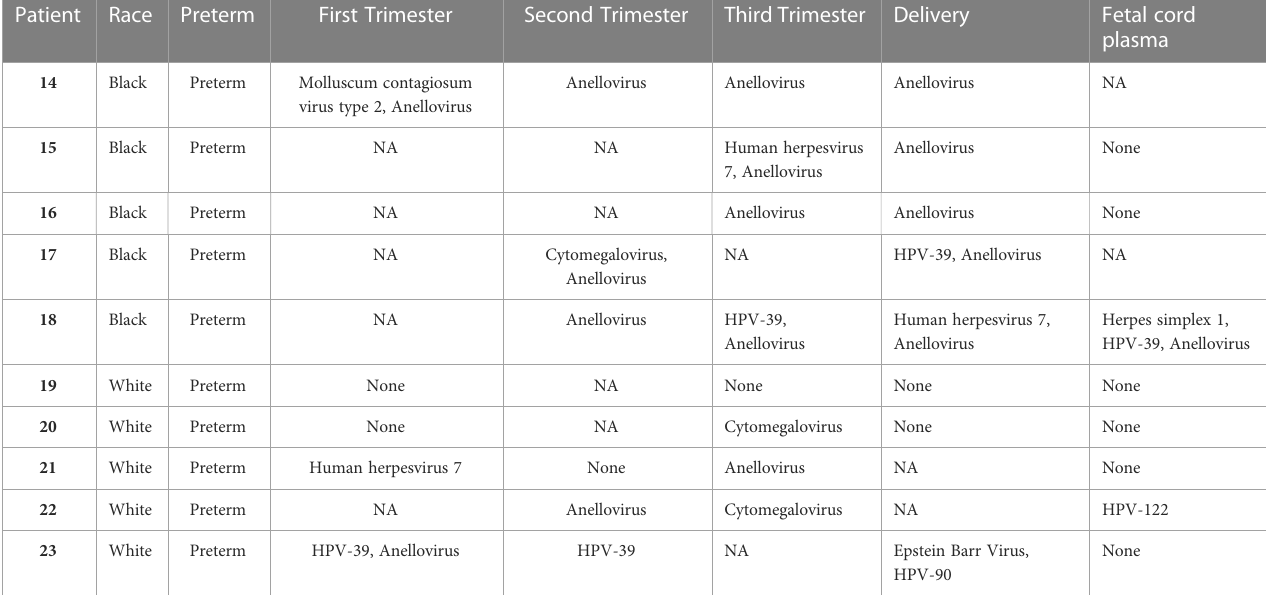
including the Betatorquevirus torque teno mini virus 3 and Gammatorquevirus torque teno midi virus 1 that were found in both cord plasma and the fi rst trimester maternal sample. While no anellovirus sequences were detected in the maternal sample at delivery, it is possible that the viral nucleic acid was below the limit of detection. No second or third trimester samples were available for that patient. In the second case, in cord plasma we detected a mixture